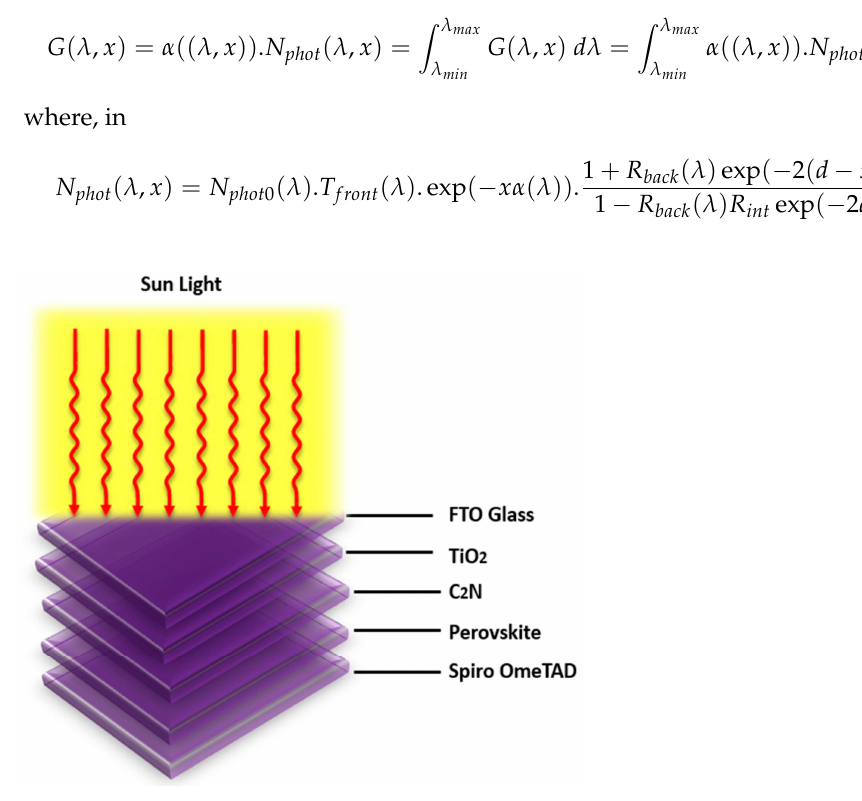
Figure 1. Proposed double-absorber-layer solar cell-layer structure.